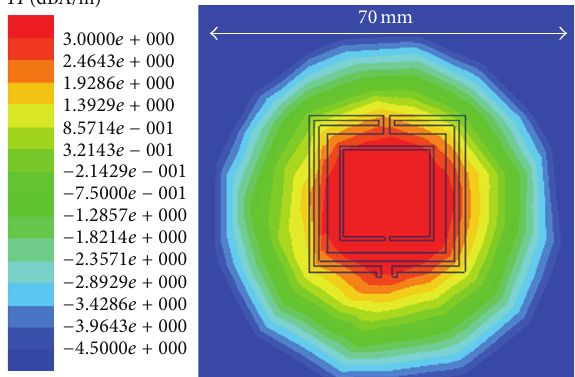
Figure 4: Near-field magnetic distribution ( 𝑥𝑦 -plane, 𝑧 = 10